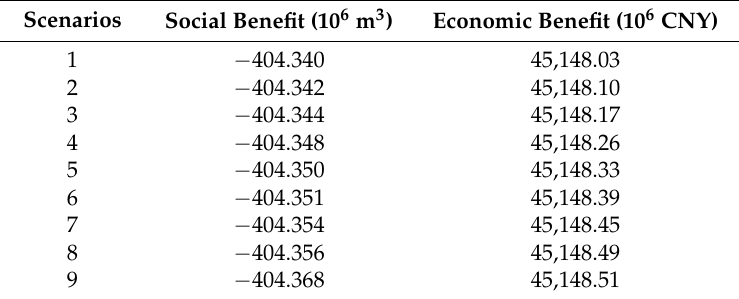
Table 4. Results of Pareto front under